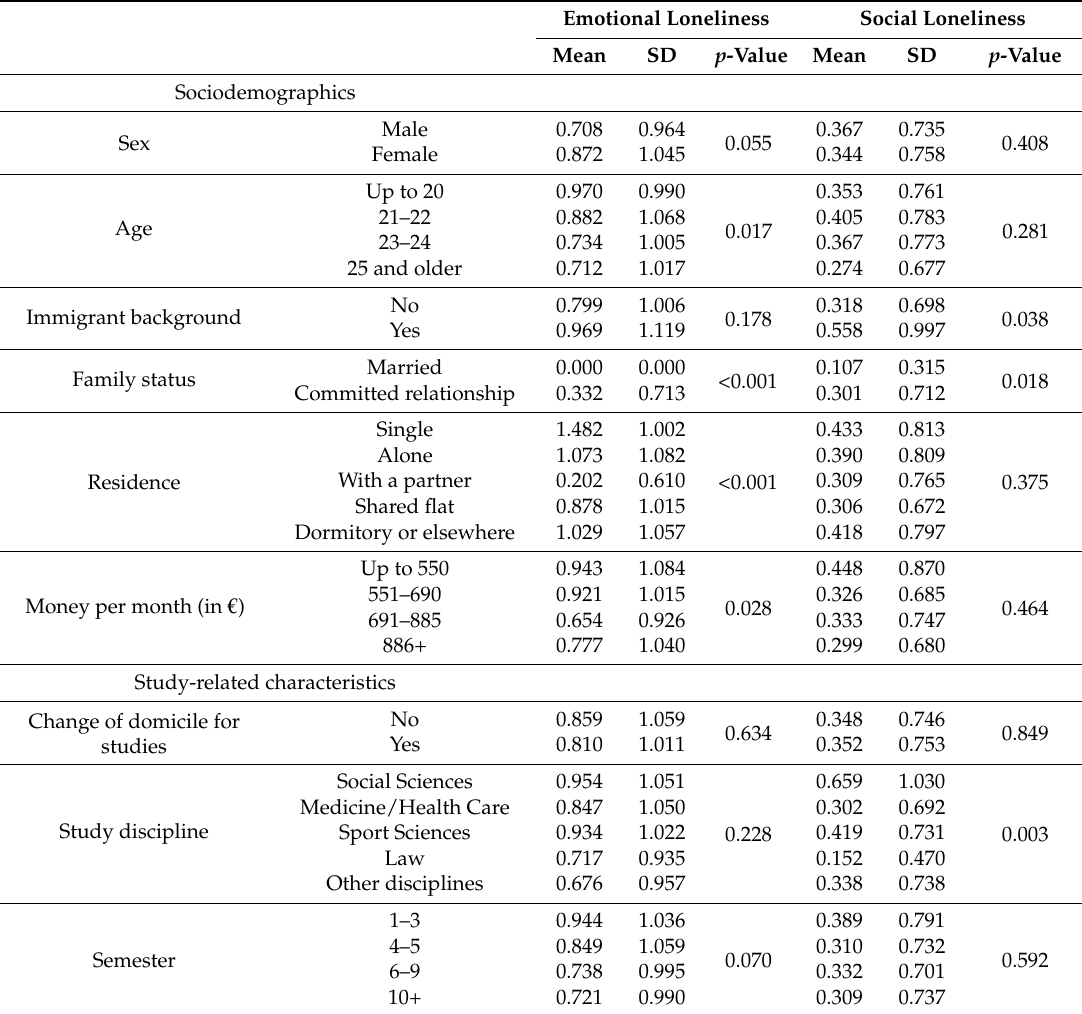
Table 2. Emotional and social loneliness by sociodemographic and study-related characteristics in university students in